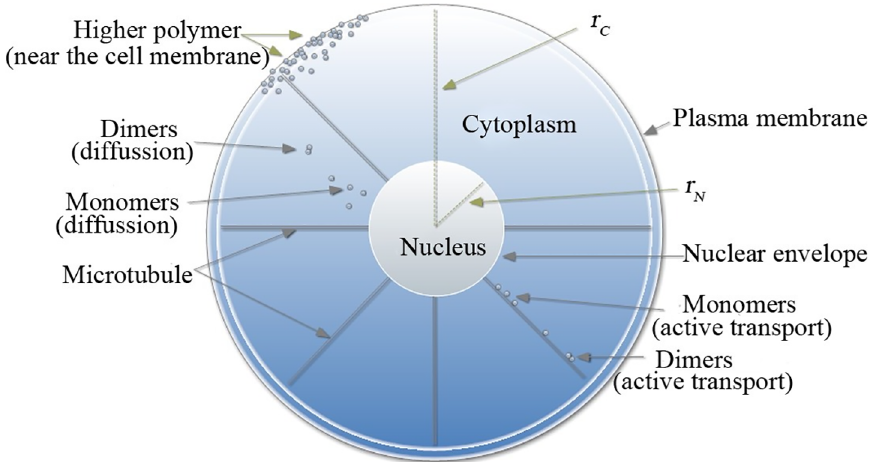
Fig 1. Schematic representation of a model cell. r N , r C are the nuclear and cellularradius, respectively.In the cytoplasm ( r N < r < r C ), Gag monomers can aggregate to dimers, but not higher-order polymers. Monomersand dimers are transported actively by molecularmotors along microtubules and can diffuse along the direction of the concentration gradient. Underneath the plasma membrane( r C ), monomers can be polymerized to